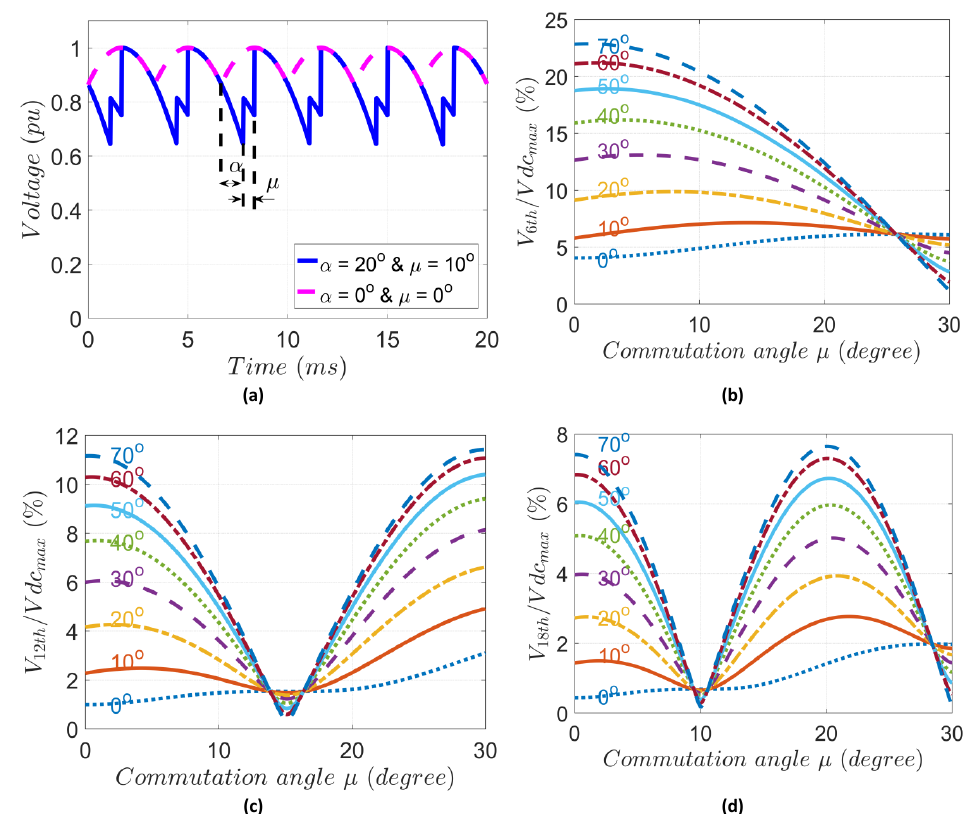
Figure 1. ( a ) Terminal voltage; ( b ) Sixth harmonic; ( c ) Twelfth harmonic; and ( d ) Eighteenth harmonic.